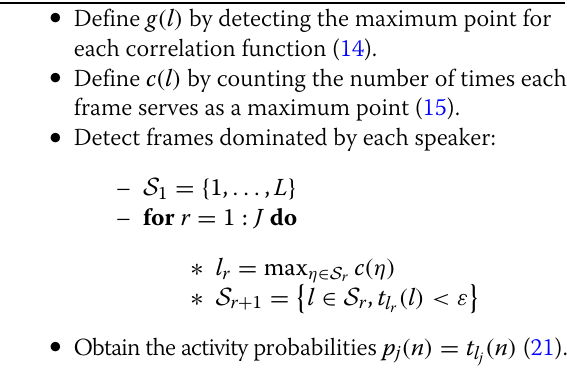
Algorithm 1: Maximum Correlation